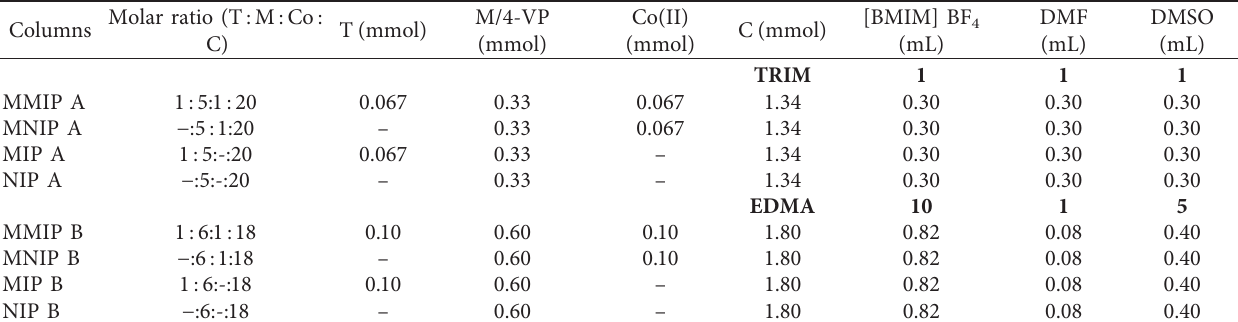
Table 1: Composition for the preparation of MMIP, MNIP, MIP, and NIP monolithic columns. Molar ratio (T :M: Co: Columns